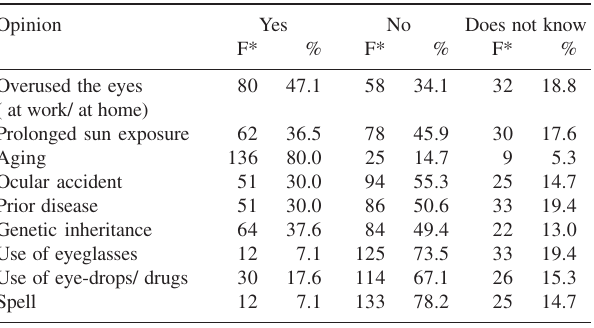
Table 3 - Opinions relating to the causes of cataract